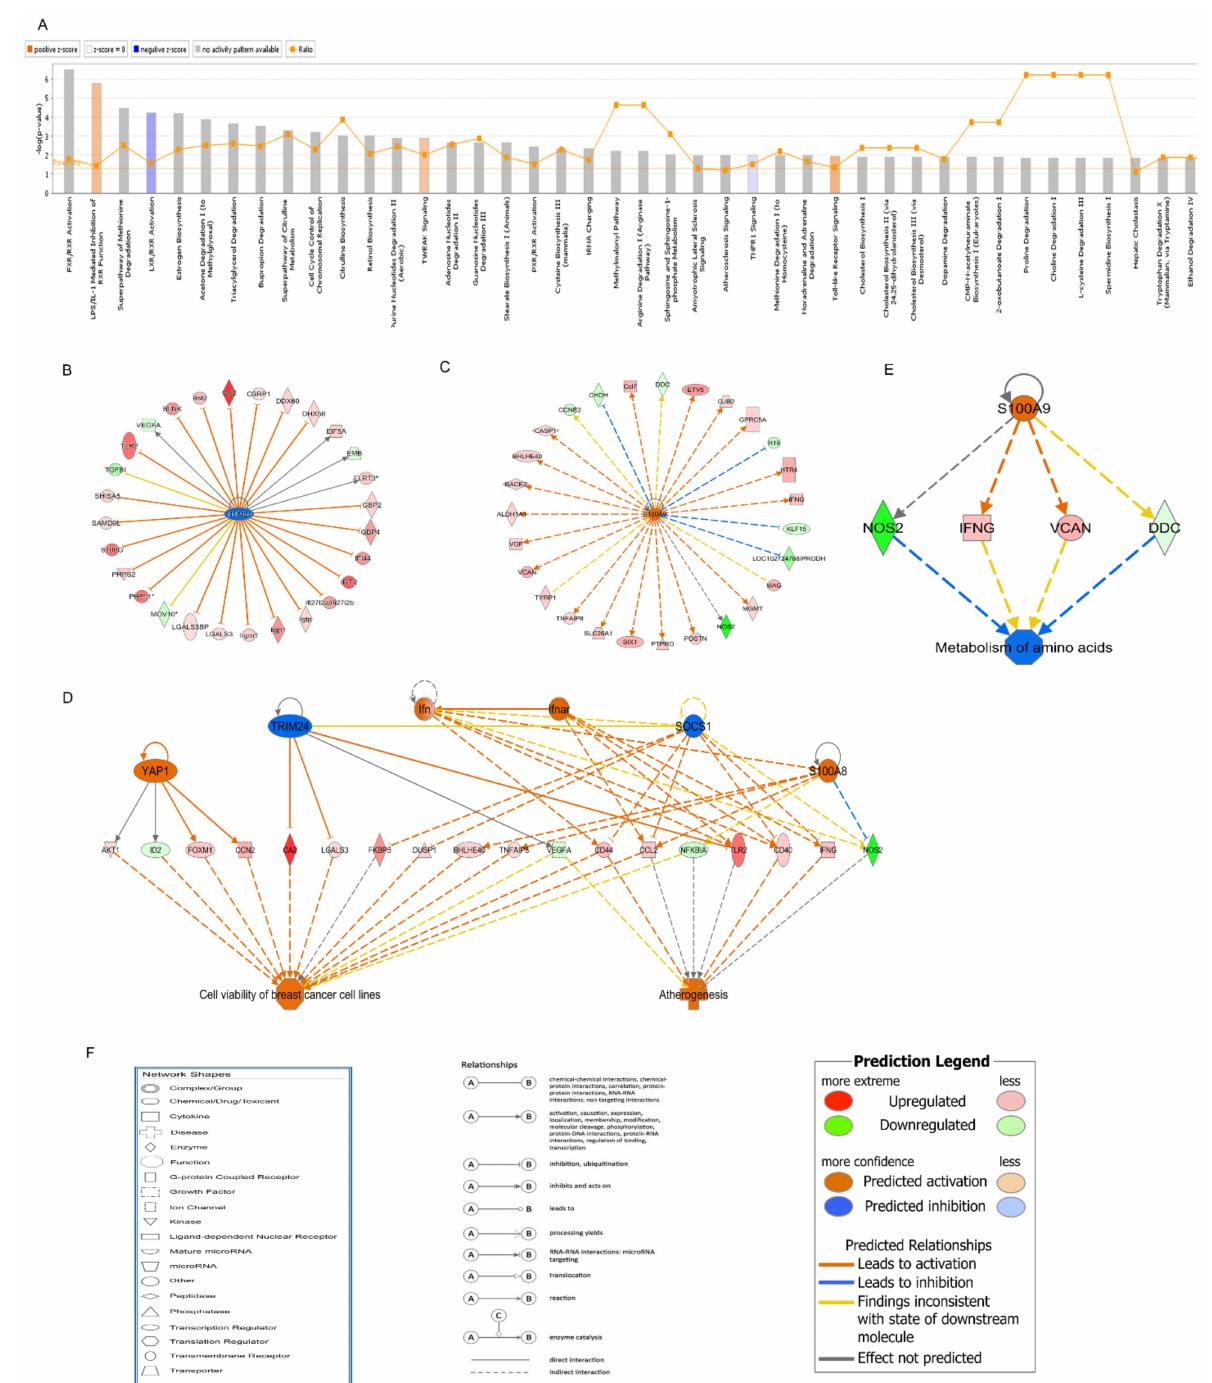
Figure 5. IPA of the small intestines from mice treated with melatonin prior to radiation. ( A ) The diagram of the top 42 canonical pathways the DEGs were involved in was analyzed. The threshold line of canonical pathways represents a p -value of 0.05. Bars crossing the threshold line represent significantly changed pathways. The ratio is the number of genes from the data set that map to the pathway divided by the total number of genes that map to the canonical pathway. A Z score >0 represents an activated state, and a Z score <0 an inhibited state. ( B ) Upstream regulatory network of TRIM24 and its targets. ( C ) Upstream regulatory network of S100A9 and its targets. ( D ) Regulator effects network that TRIM24 was involved in. ( E ) Regulator effects network that S100A9 was involved in. ( F ) The representative meaning of the symbols in the figures. Genes or gene products are expressed as nodes, and the biological co-relationship between two nodes is indicated by the connecting lines. Nodes are represented using diverse shapes that express the functional class of the gene product. The degree of the node color indicates the level of upregulation (red) or downregulation (green). n = 3